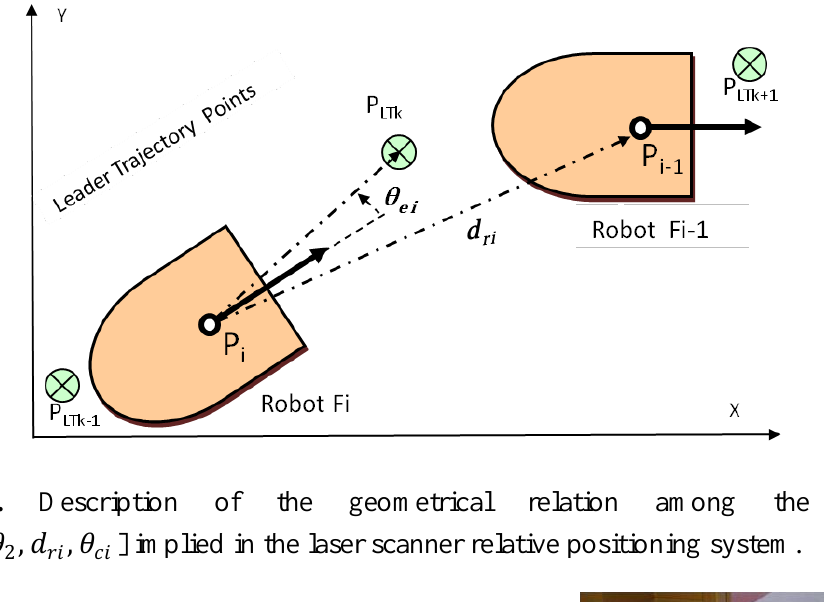
Figure 4. Variables involved in the high level control of the platoon: points of the leader trajectory, pose of each follower and relative position information obtained through the laser scanner.